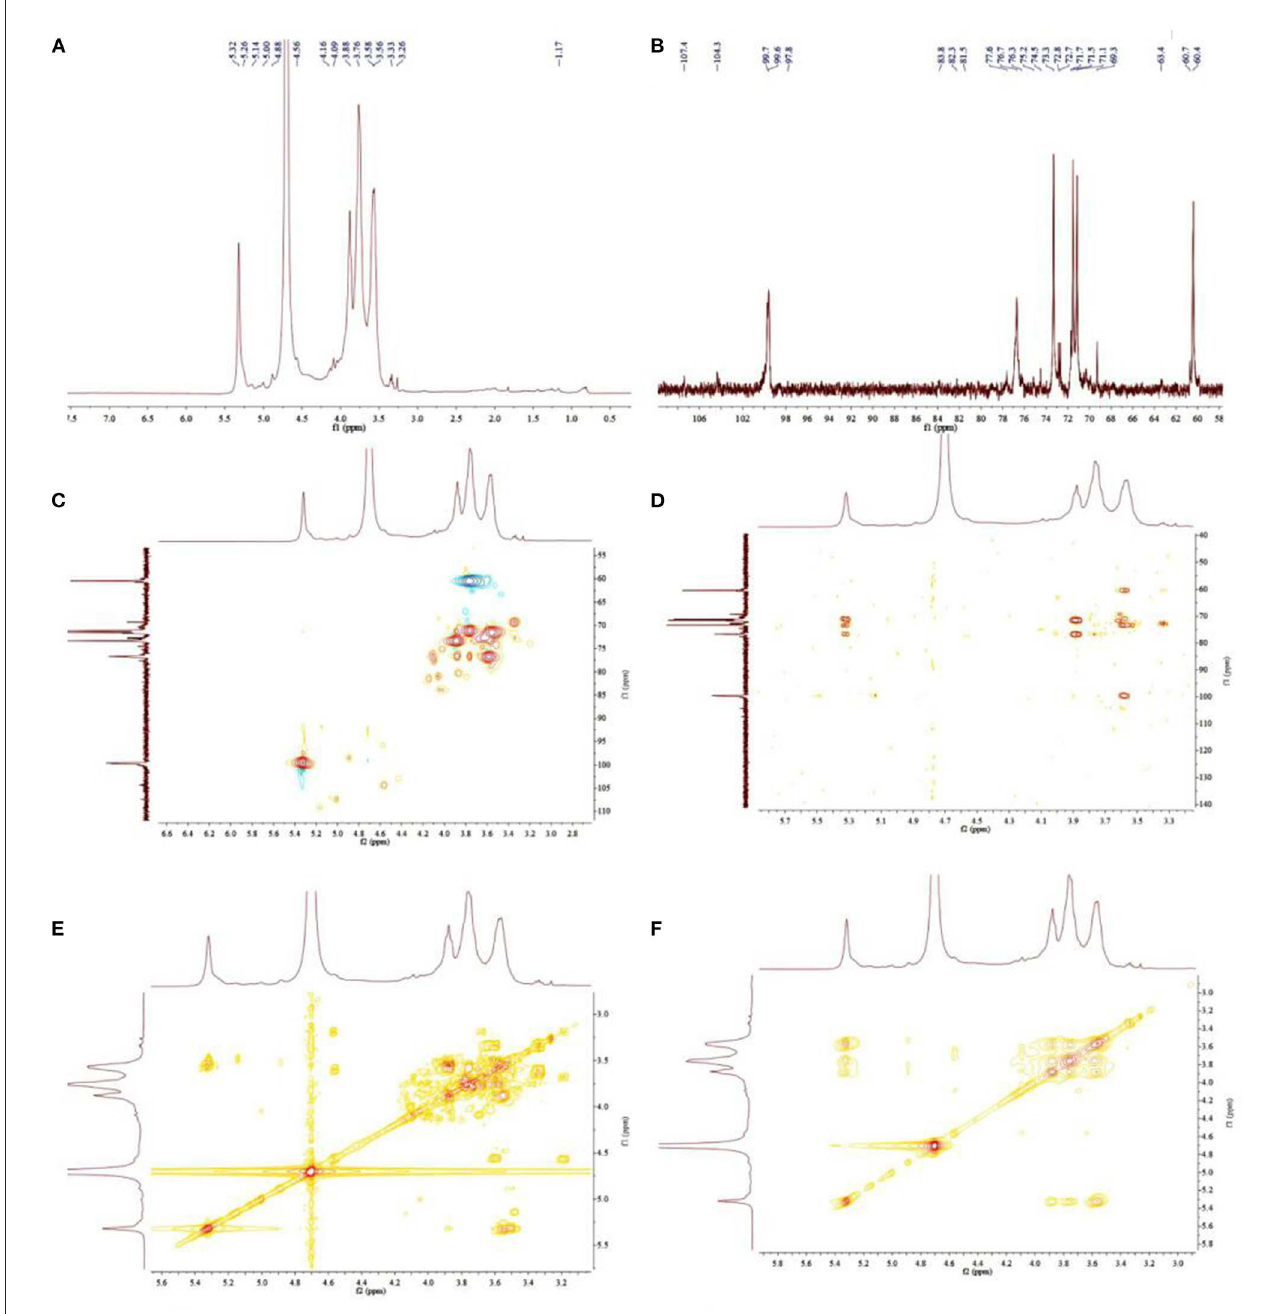
(Figure 5), the 1H-13C correlations from the anomeric protons H- 1 ( δ H 5.32) to C-2 and C-3, and H2-6 ( δ H 3.76) to C-4 and C-5, demonstrated the prominent glycosidic linkages as → 4)- α -D-Glcp- (1 → . Furthermore, through anomeric terminal based signals C-1/H- 1 at values of 99.7/5.28, 107.4/5.01, 97.4/5.31, and 104.3/4.56,